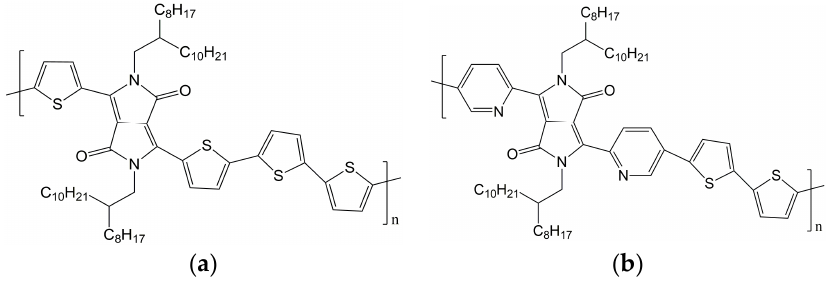
Figure 1. Chemical structures of PDPP4T ( a ) and DPPDPyBT ( b ).